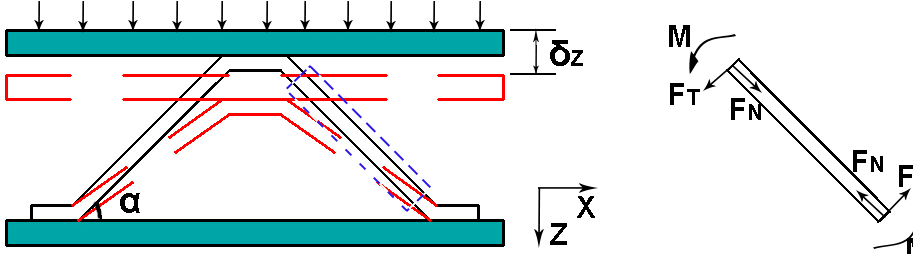
Figure 6. The loading and boundary conditions of the strut in the Z-direction.